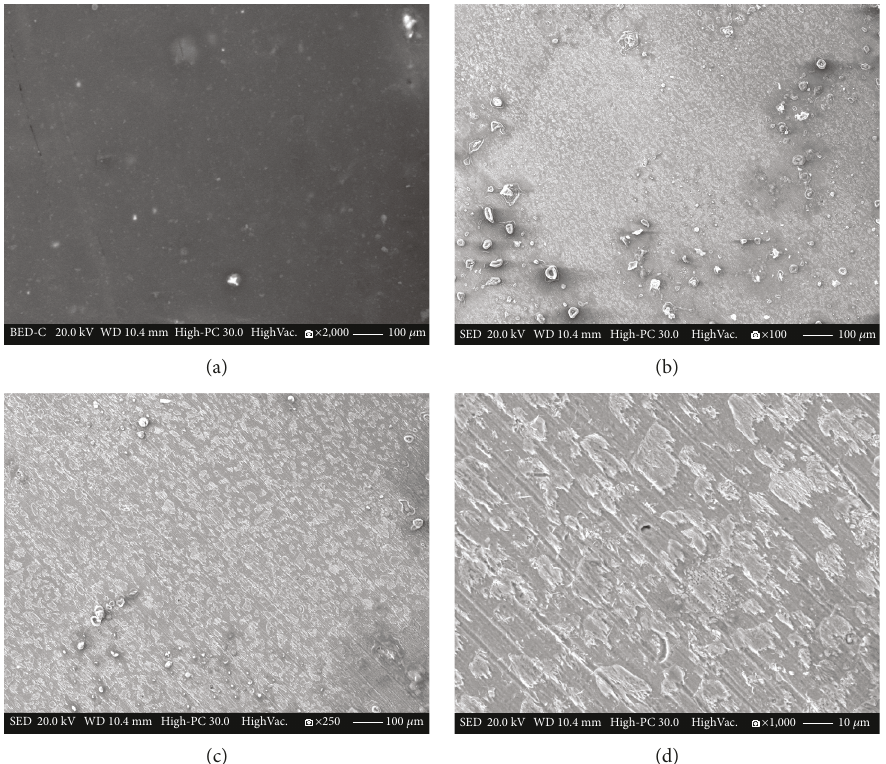
Figure 18: Morphological aspects of carbon steel coated with a fi lm of chitosan doped with 100ppm of nanoparticles, after 24 hours of immersion in a 3.5% NaCl solution at room